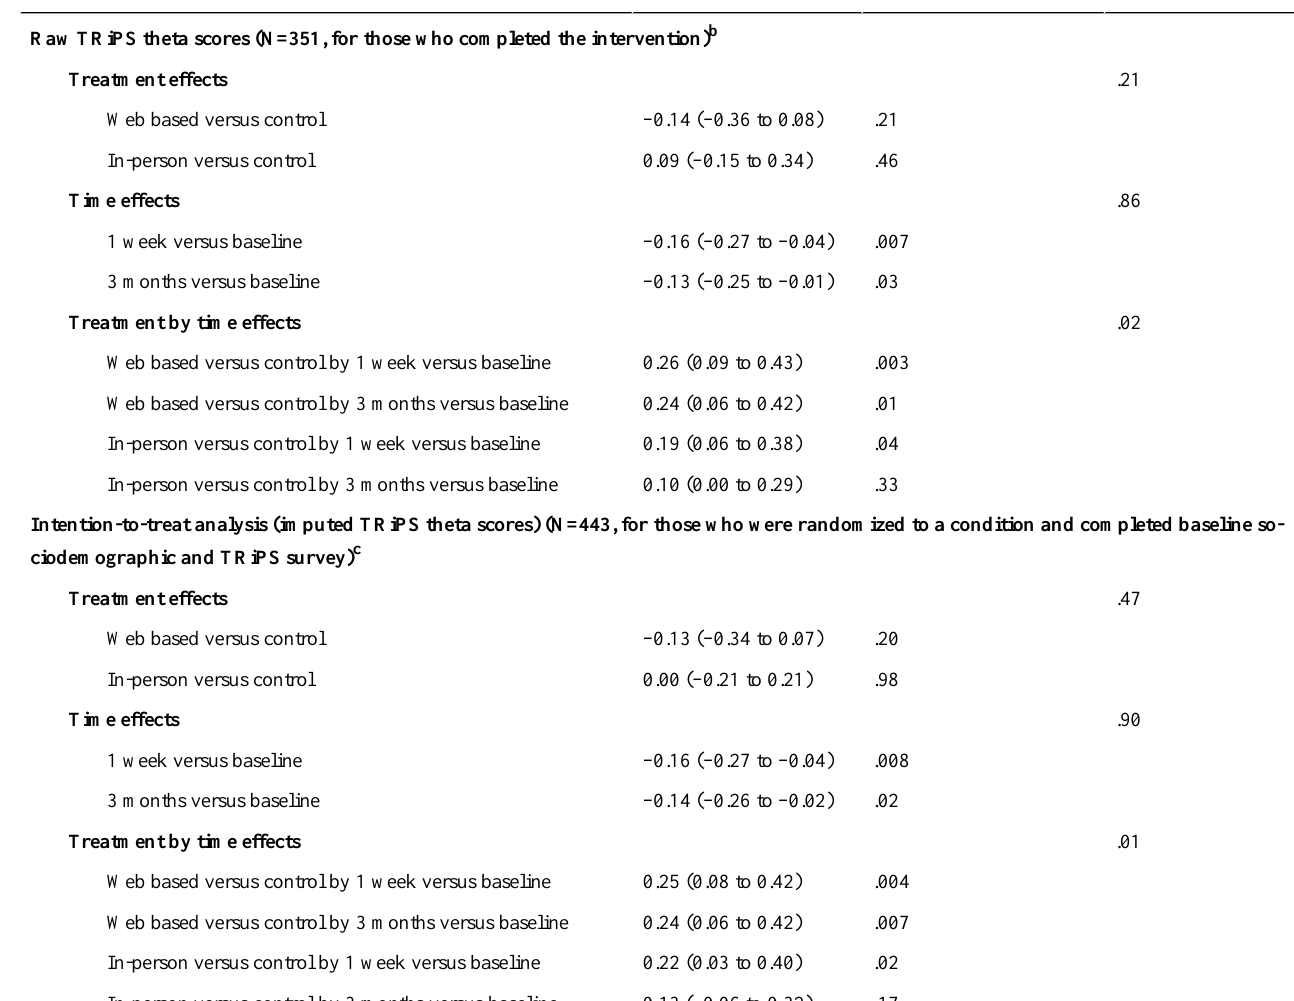
Table 3. Results of mixed effects regression analysis for change in TRiPS a scores by treatment condition and time point. Raw TRiPS theta scores (N=351, for those who completed the intervention) b